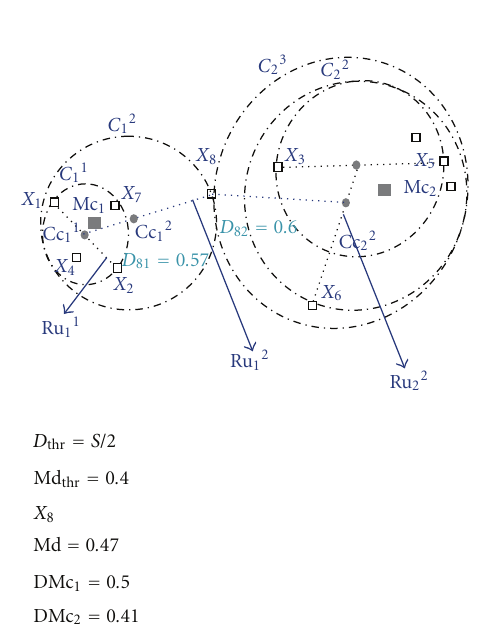
Figure 2: A brief clustering process using LEFCM with input vectors x 1 to x 8 in a 2D space. x 1 causes the LEFCM to create a new and radius Ru 0 1 = 0; x 2 update cluster cluster C 0 1 with center Cc 0 1 C 0 1 → C 1 ; x 3 : create a new cluster Cc 2 1 1 with center Cc 1 do nothing; x 5 and x 6 update cluster C 1 2 → C 2 2 ; x 8 update cluster C 1 2 → C 2 1 1 with center Cc 1